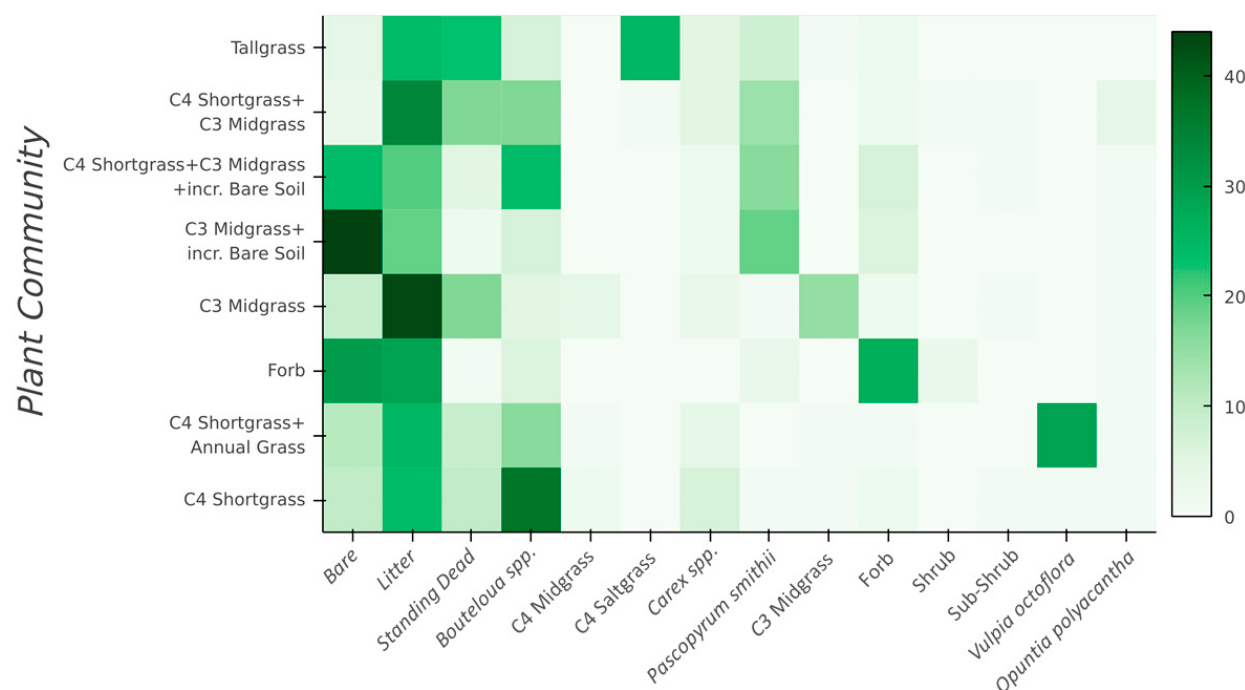
Figure 2. Average plant community class ( Y -axis) composition derived from the 175 vegetation transects throughout CPER. The vegetation components on the X -axis are directly related to Table 1, except Bouteloua spp. = C4 Shortgrasses, and C3 Midgrass = C3 Needle and thread ( Hesperostipa comata ) + C3 Squirreltail ( Elymus elymoides